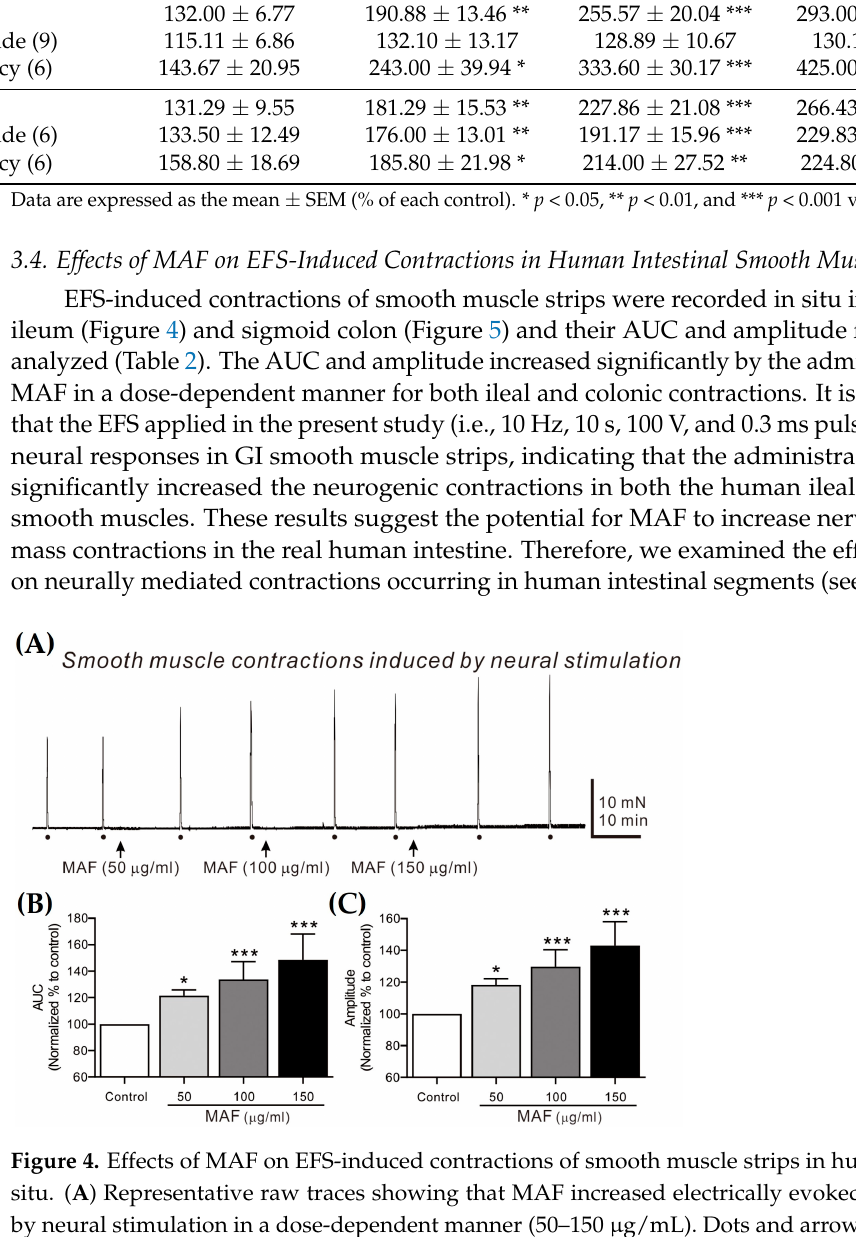
e ff ects of MAF on ( B ) AUC and ( C ) amplitude of contractions. Signi fi cant di ff erence (* p < 0.05 and *** p < 0.001) compared with control.